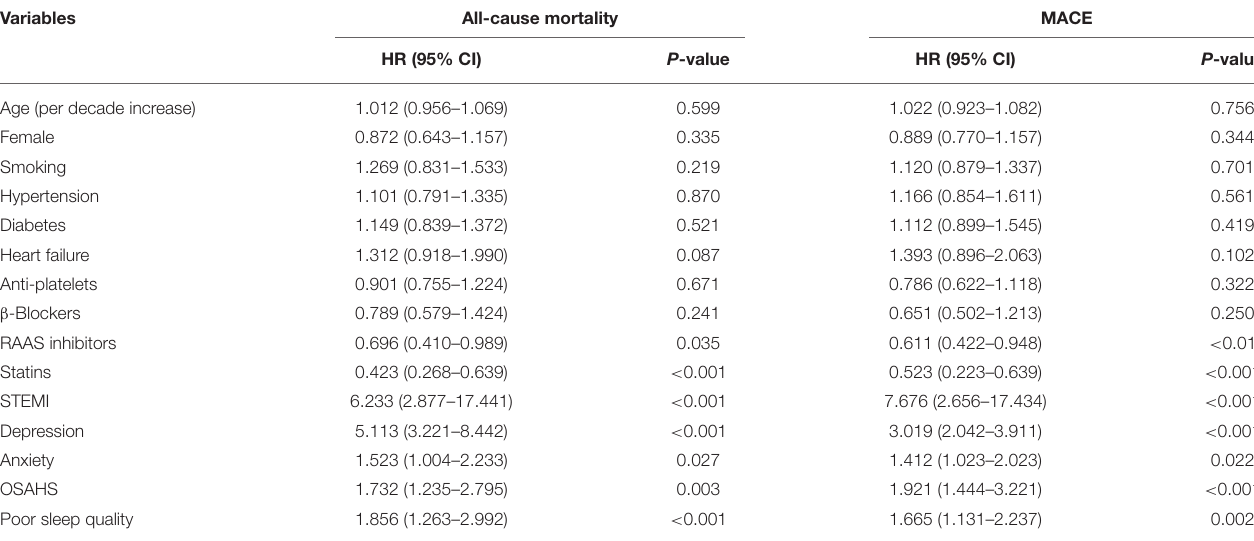
TABLE 4 | Univariate Cox regression of variables influencing all-cause mortality and MACE.